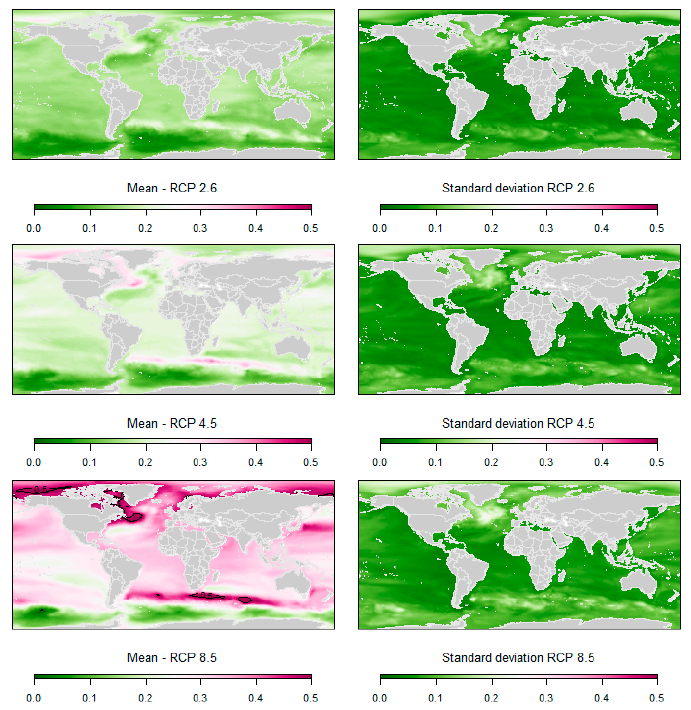
Figure A3. Mean and standard deviation of sterodynamic sea-level changes (in m, for 2099 with respect to 1986–2005) for RCP2.6, RCP4.5 and RCP8.5 by 2099.